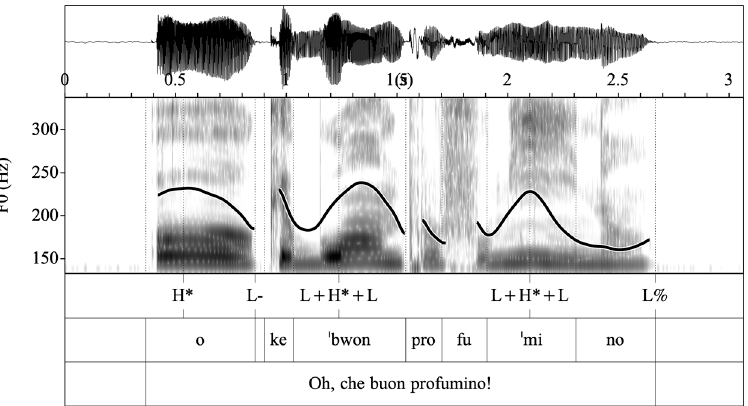
Figure 17. Waveform, spectrogram and F0 trace of the what -exclamative Che buon profumino! in L2 Italian (F32, level B1) produced with the target-like L+H*+L L% pattern.